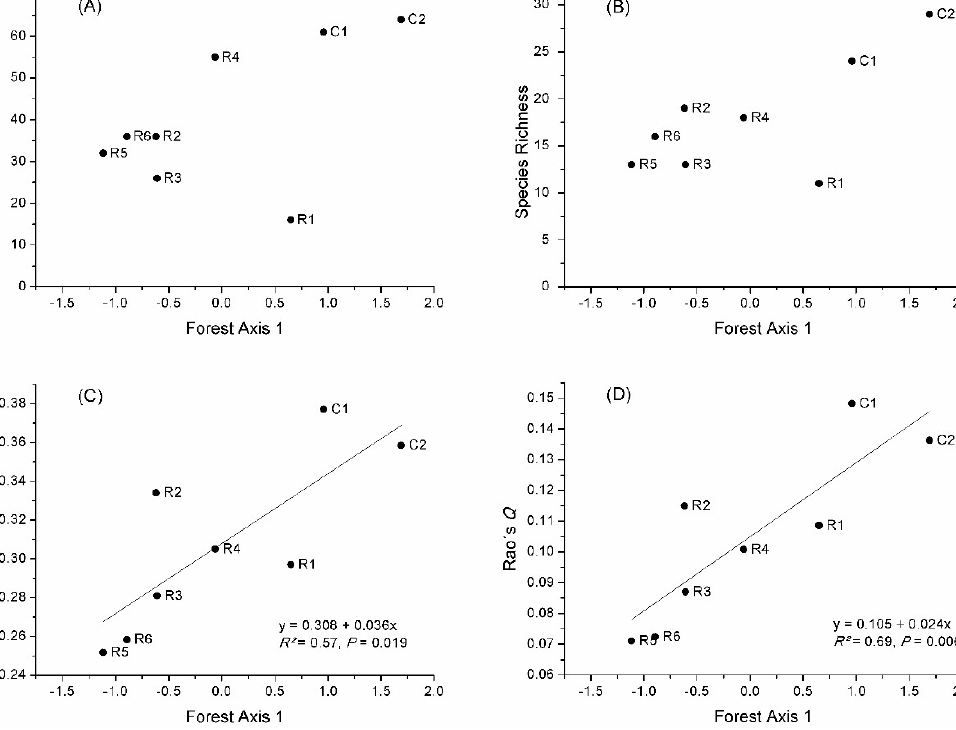
Figure 2. Relationships between bird assemblage descriptors ( A ) abundance, ( B ) species richness, ( C ) functional dispersion, and ( D ) Rao’s quadratic entropy and Forest Axis 1 in reference (C1 and C2) and under restoration (R1–R6) sites, with results of significant linear regression models.